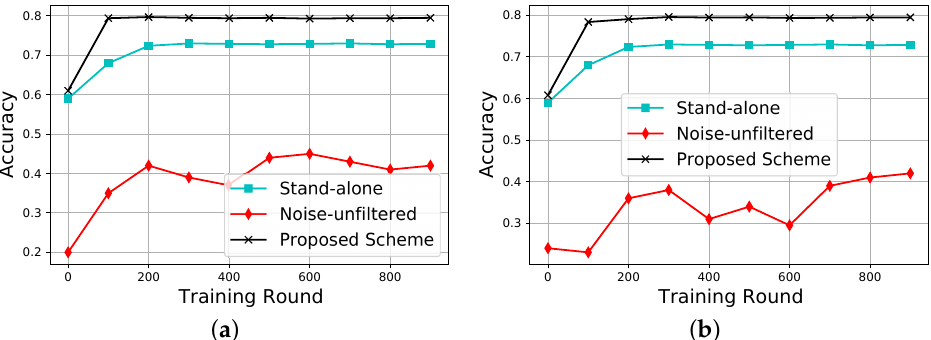
Figure 5. Training convergence against the number of training rounds. ( a ) NDP noise data are 30%. ( b ) NDP noise data are 50%.